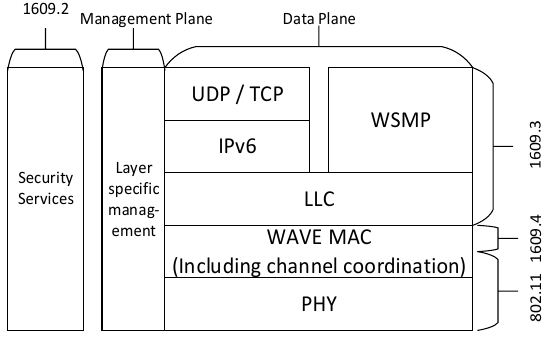
Figure 1. WAVE protocol stack and different standards.